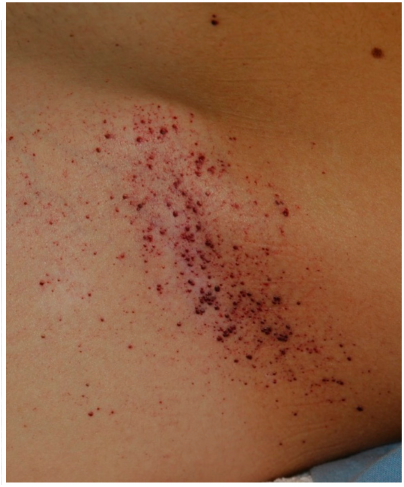
Figure 1. Multiple angiokeratomas on the right hip of a 33-year-old man.